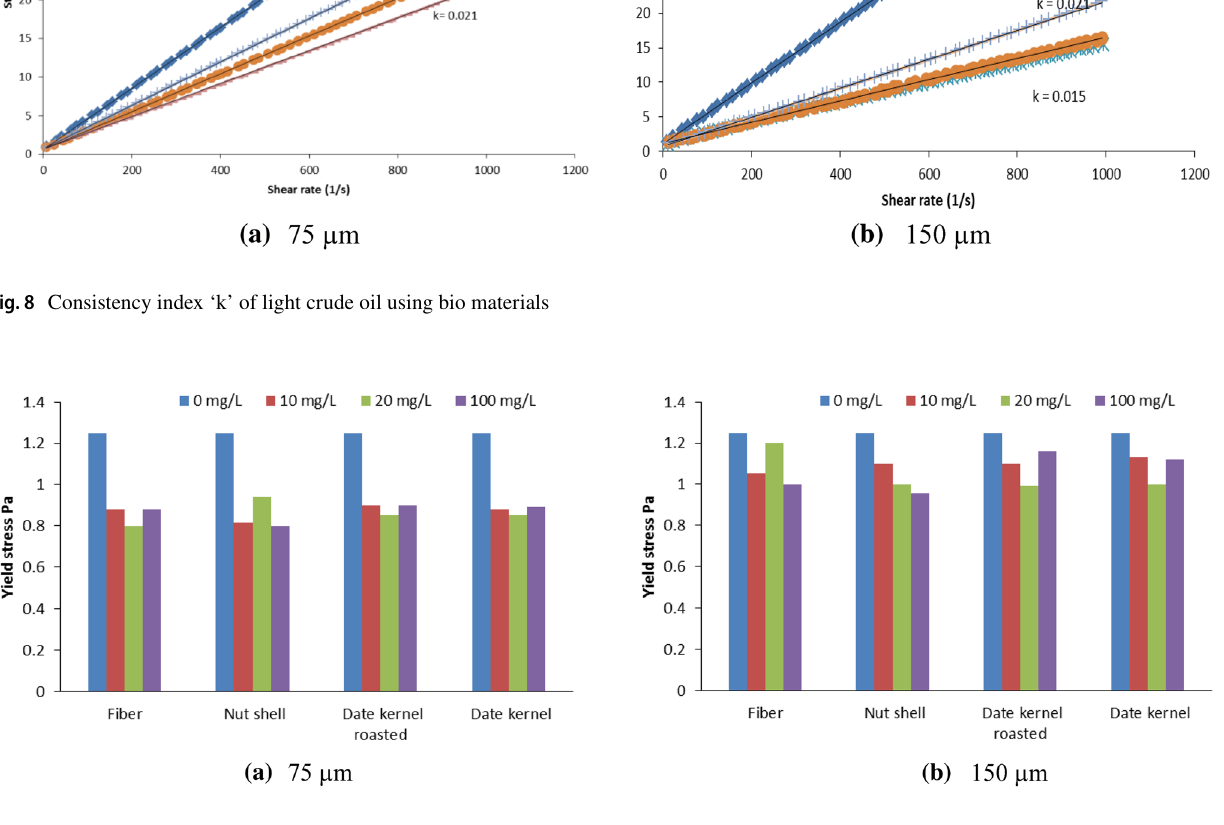
Fig. 9 Yield stress of light crude oil using bio materials